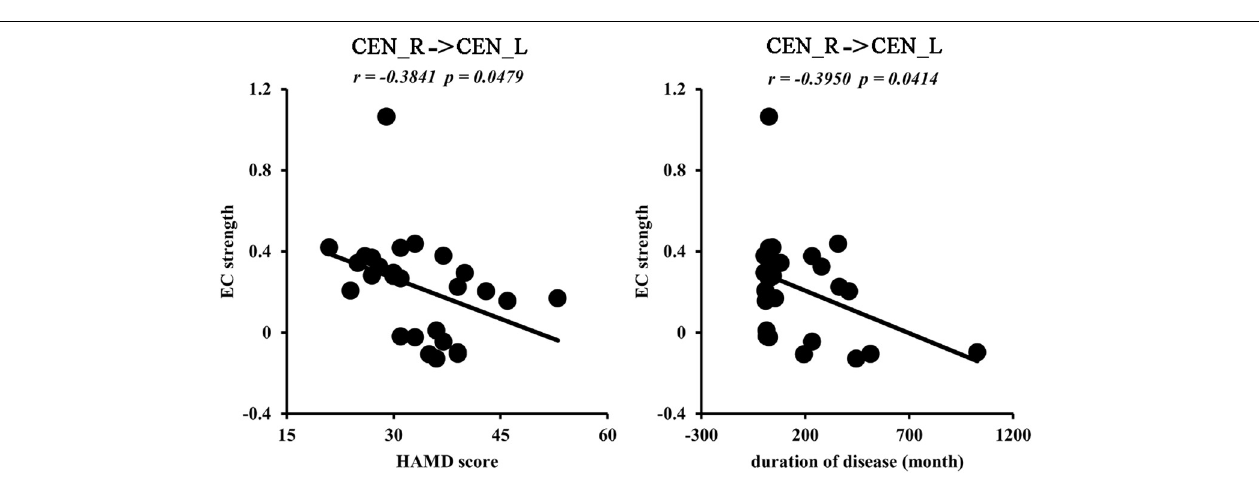
FIGURE 5 | Correlation analyses. The significantly negative correlations between effective functional connectivities from right to left central network networks (CEN) and Hamilton Depression Rating Scale (HAMD) scores, disease duration were found in MDD